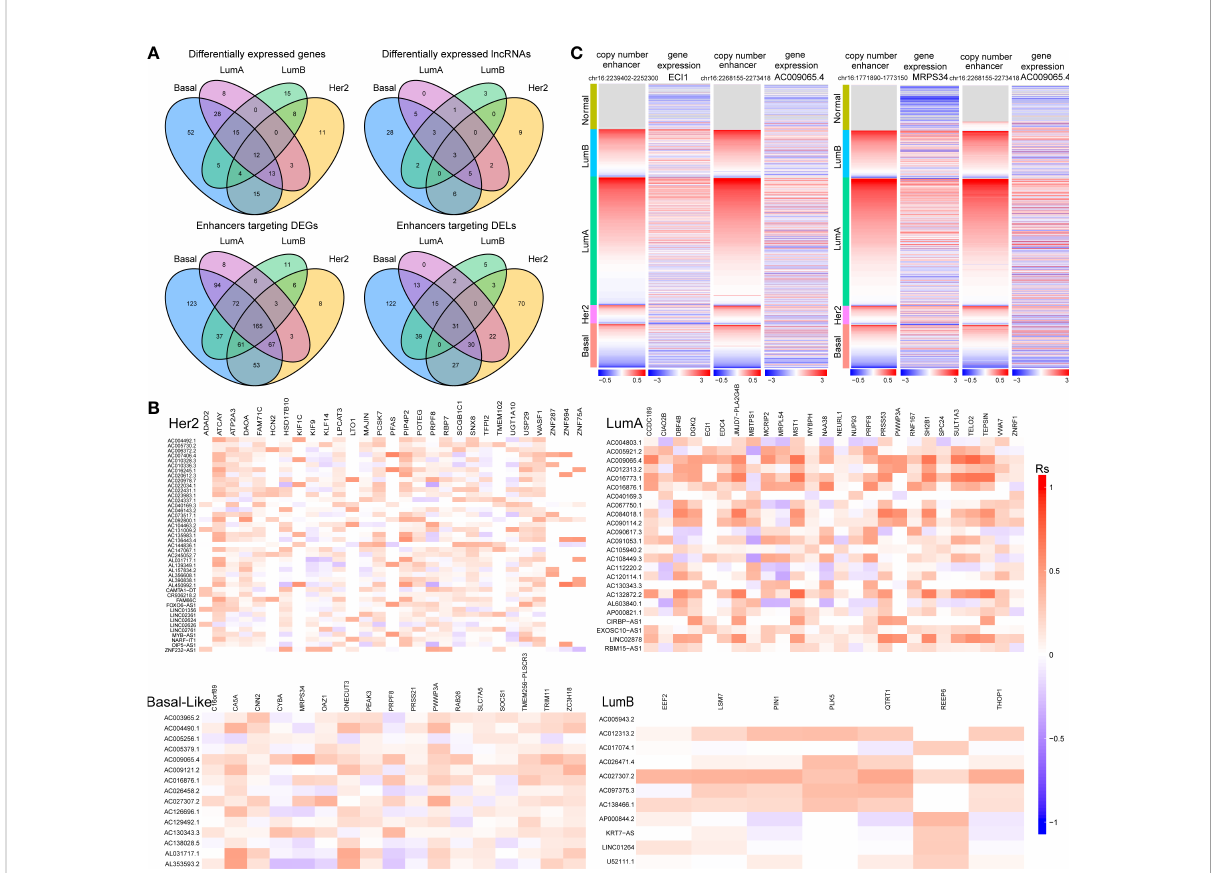
FIGURE 3 The relationship between CNV-driven enhancer target genes and related lncRNAs (A) Venn diagram analysis of CNV-driven enhancer target genes and related lncRNAs of four subtypes of breast cancer. The top panel shows the CNV-driven enhancer target genes and related lncRNAs, respectively, in the four subtypes. The bottom panel shows the enhancers of DEGs and the enhancers of DELs in the four subtypes. (B) Correlation analysis of differentially expressed genes and differentially expressed lncRNAs in four subtypes of breast cancer. X-axis is symbol of DEGs and y-axis is symbol of DELs. (C) Copy number variation of enhancers (chr16:2239402-2252300; chr16:1771890-1773150; chr16:2268155-2273418) and expression levels of ECI1, MRPS34 and AC009065.4 in breast cancer